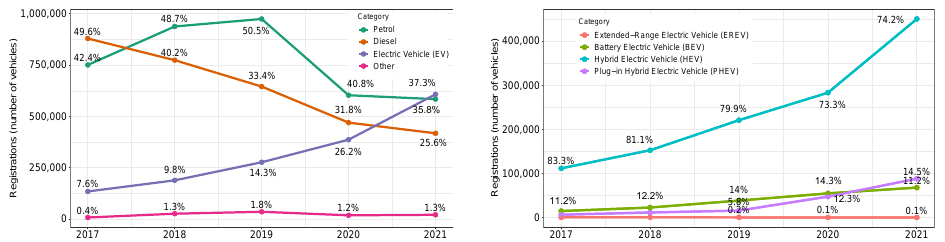
Figure 11. Total vehicle registrations ( left ) and electric vehicle registrations ( right ) according to the category during the period of 2017–2021 in Spain. The percentages of registrations of each type of vehicle were obtained for each year. Source: Dirección General de Tráfico, Spain.